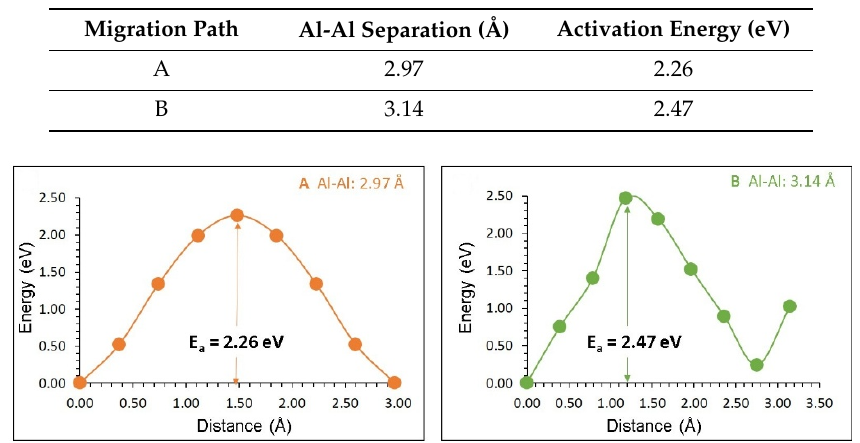
Table 5. Local Al-Al hops, their jump distances and activation energies for the Al ion migration in Al 2 SiO 5 as reported in the Figure 3.